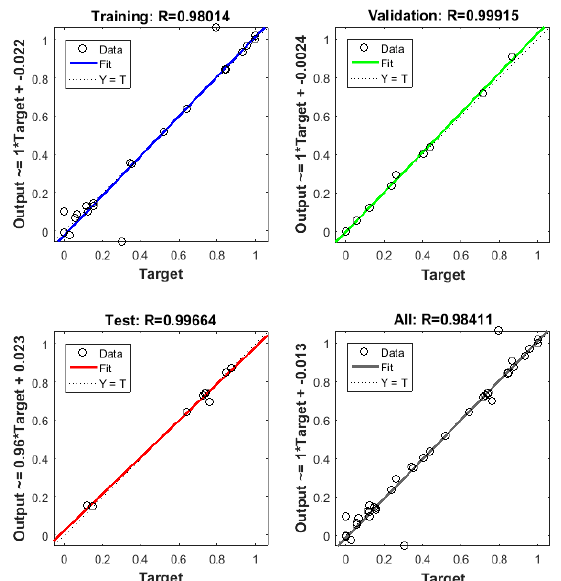
Figure 7. Regression plots of predicted values ( -- ) vs. experimental data ( o ).